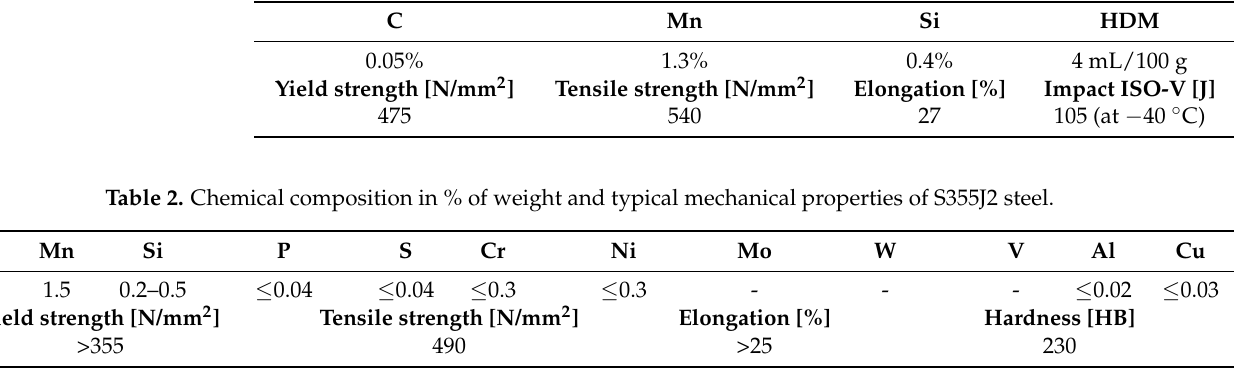
Table 1. Chemical composition in % of weight and typical mechanical properties of BASIC 7018 electrodes.